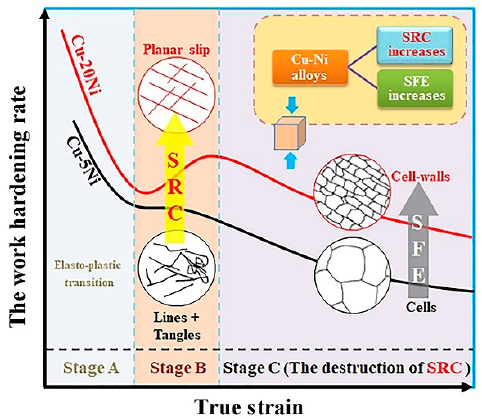
Figure 6. Schematic illustration showing the influence of SRC on the work-hardening behavior and deformation microstructures of Cu–Ni alloys.